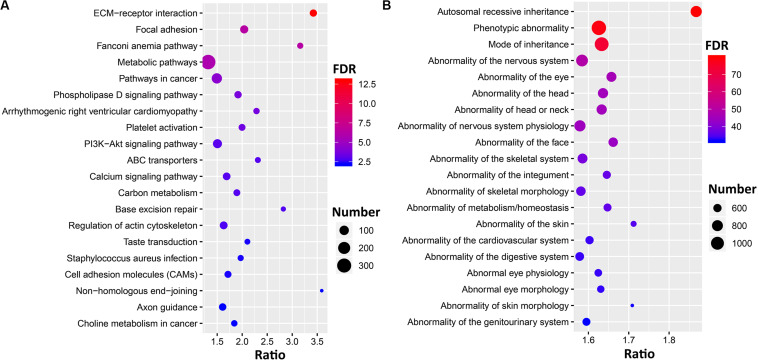
Gene set enrichment analysis for the genes with loss-of-function variants. Bubble plots showing the top 20 significant results [false discovery rate (FDR) < 0.05] for Kyoto Encyclopedia of Genes and Genomes (KEGG) pathways (A) and human phenotype ontology (HP) terms (B). The circles represent the number of enriched genes, and the colors represent log10 transformed FDR values.